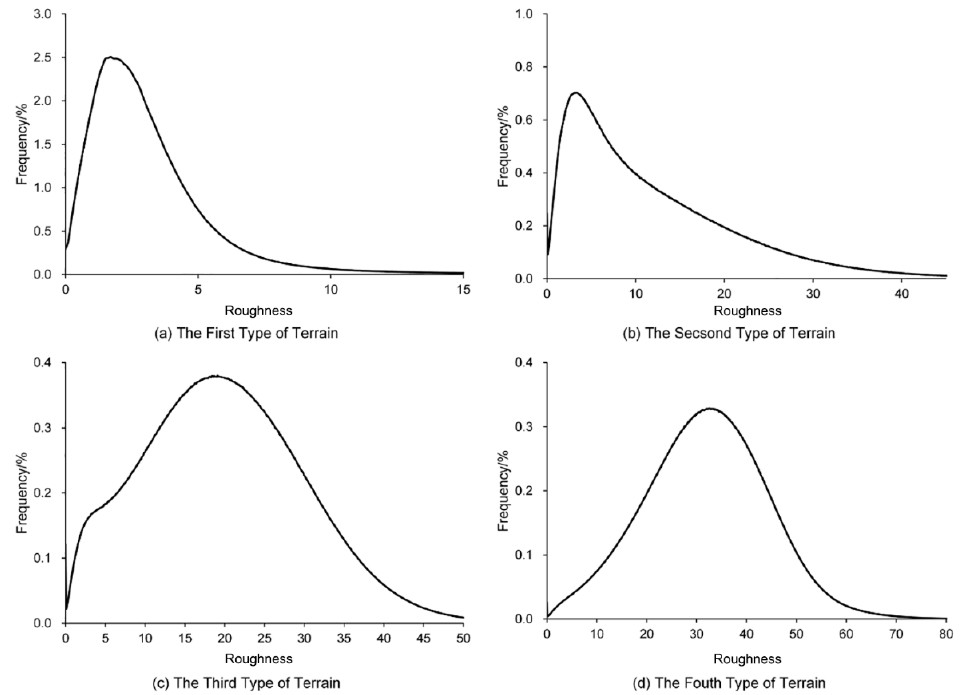
Figure 9. ( a ) Frequency curves of the SLOPE partition of plain; ( b ) Frequency curves of the SLOPE partition of high-altitude platforms and low-altitude hills; ( c ) Frequency curves of the SLOPE partition of high-altitude hills and low-relief mountains; ( d ) Frequency curves of the SLOPE partition of high-relief mountains.